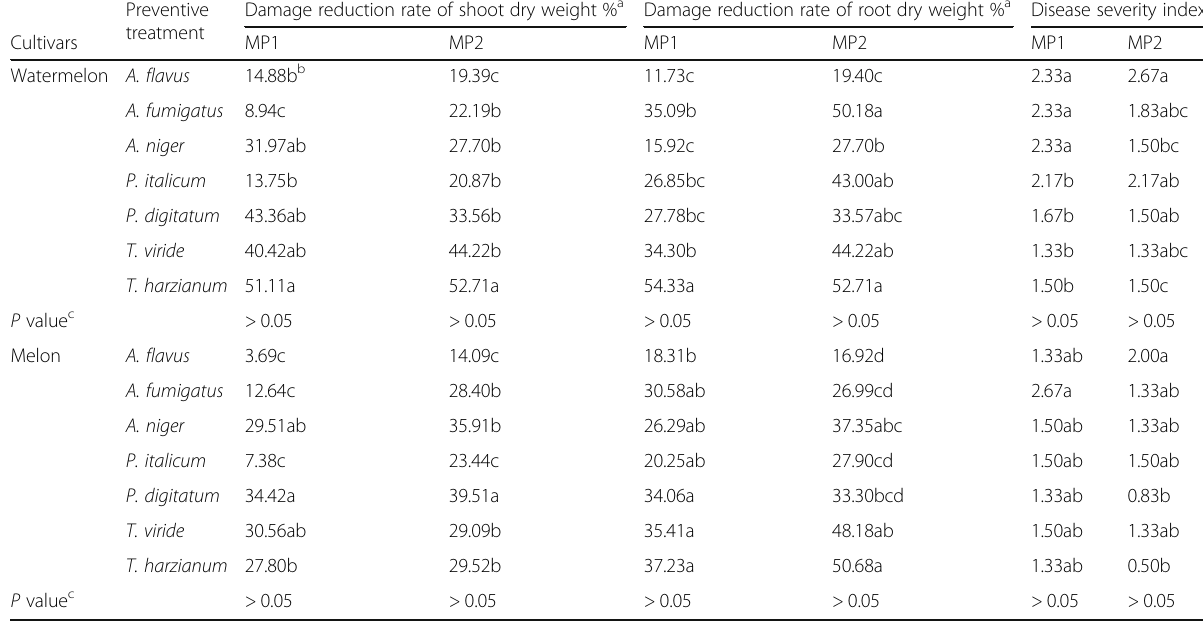
Table 7 Damage reduction rate of top and root dry weight (%) and disease severity index values recorded by watermelon and melon seedlings inoculated with two M. phaseolina isolates and treated preventively by four Aspergillus spp. isolates, two Penicillium spp. isolates, and two Trichoderma spp. isolates in vivo assay